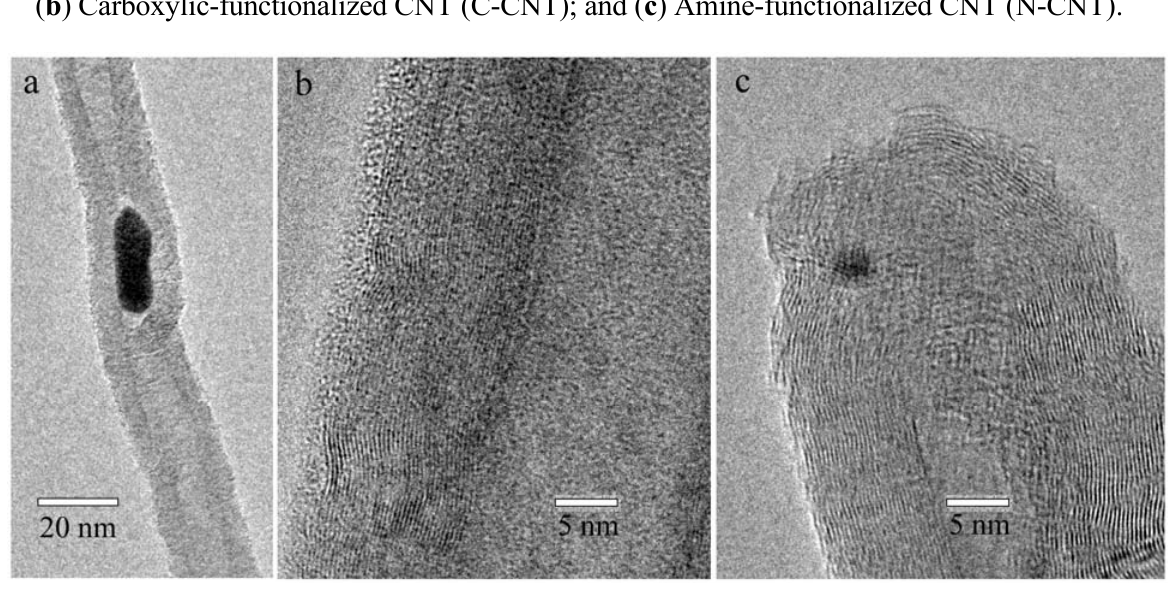
Figure 1. High-resolution transmission electron microscope (HRTEM) microstructures